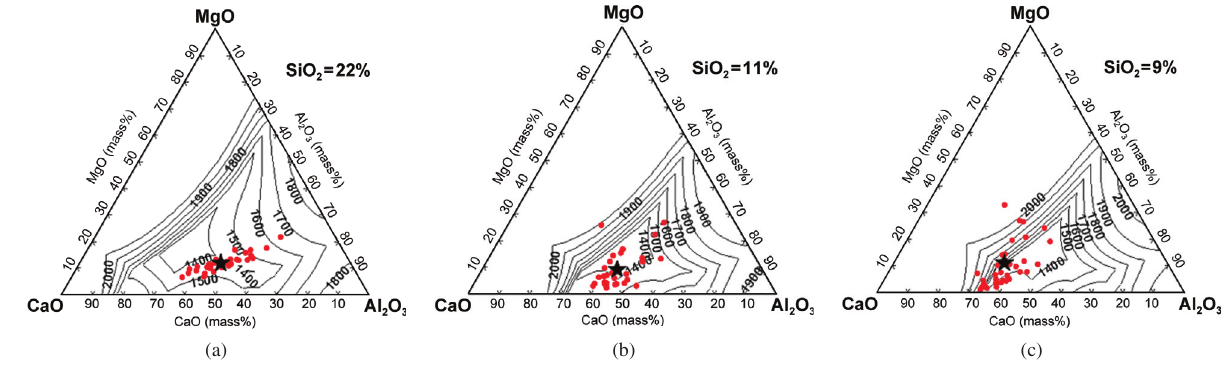
Figure 3 : Composition distribution of inclusions under different basicity slag conditions. (a) Slag No. 1 ( B : 1.93); (b) slag No. 2 ( B : 3.26); (c) slag No. 3 ( B : 4.54).